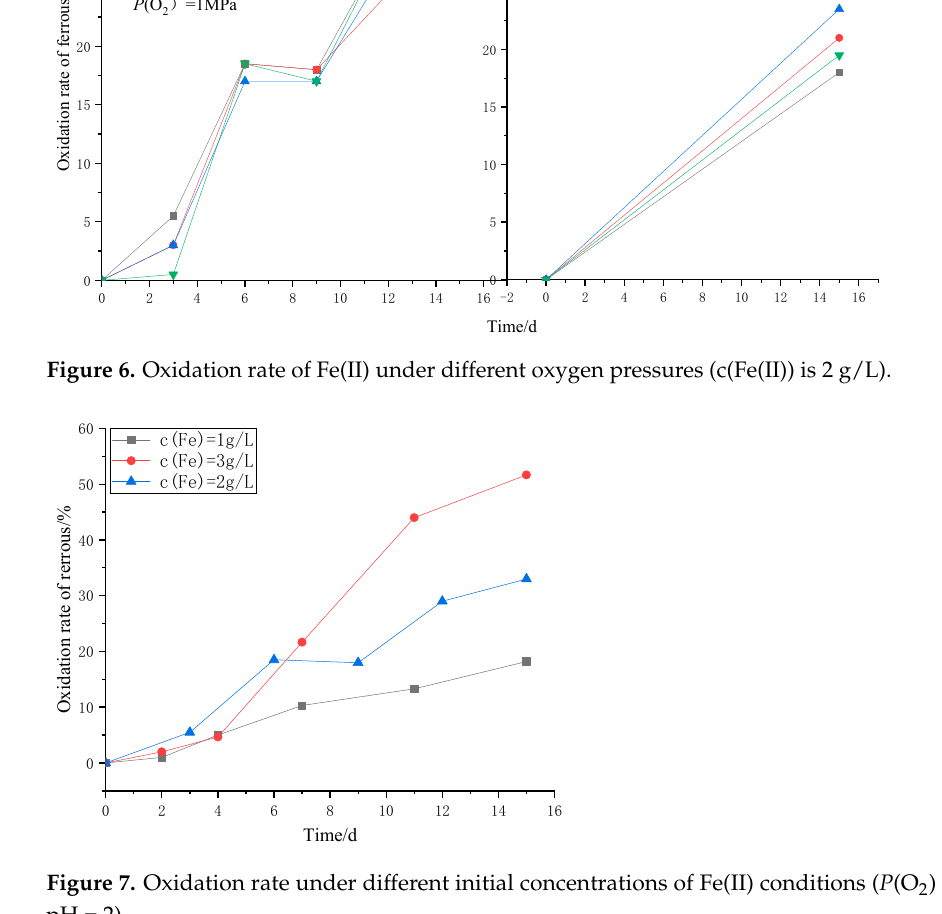
Figure 7. Oxidation rate under different initial concentrations of Fe(II) conditions ( P (O 2 ) = 1 MPa, pH = 2).